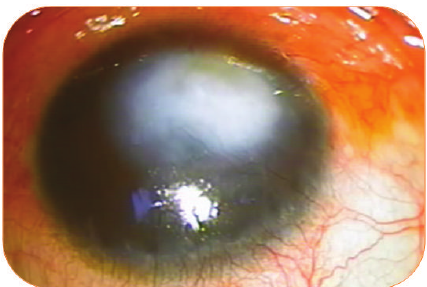
Figure 1: Deep neovascularization in a patient with posttraumatic opacity.